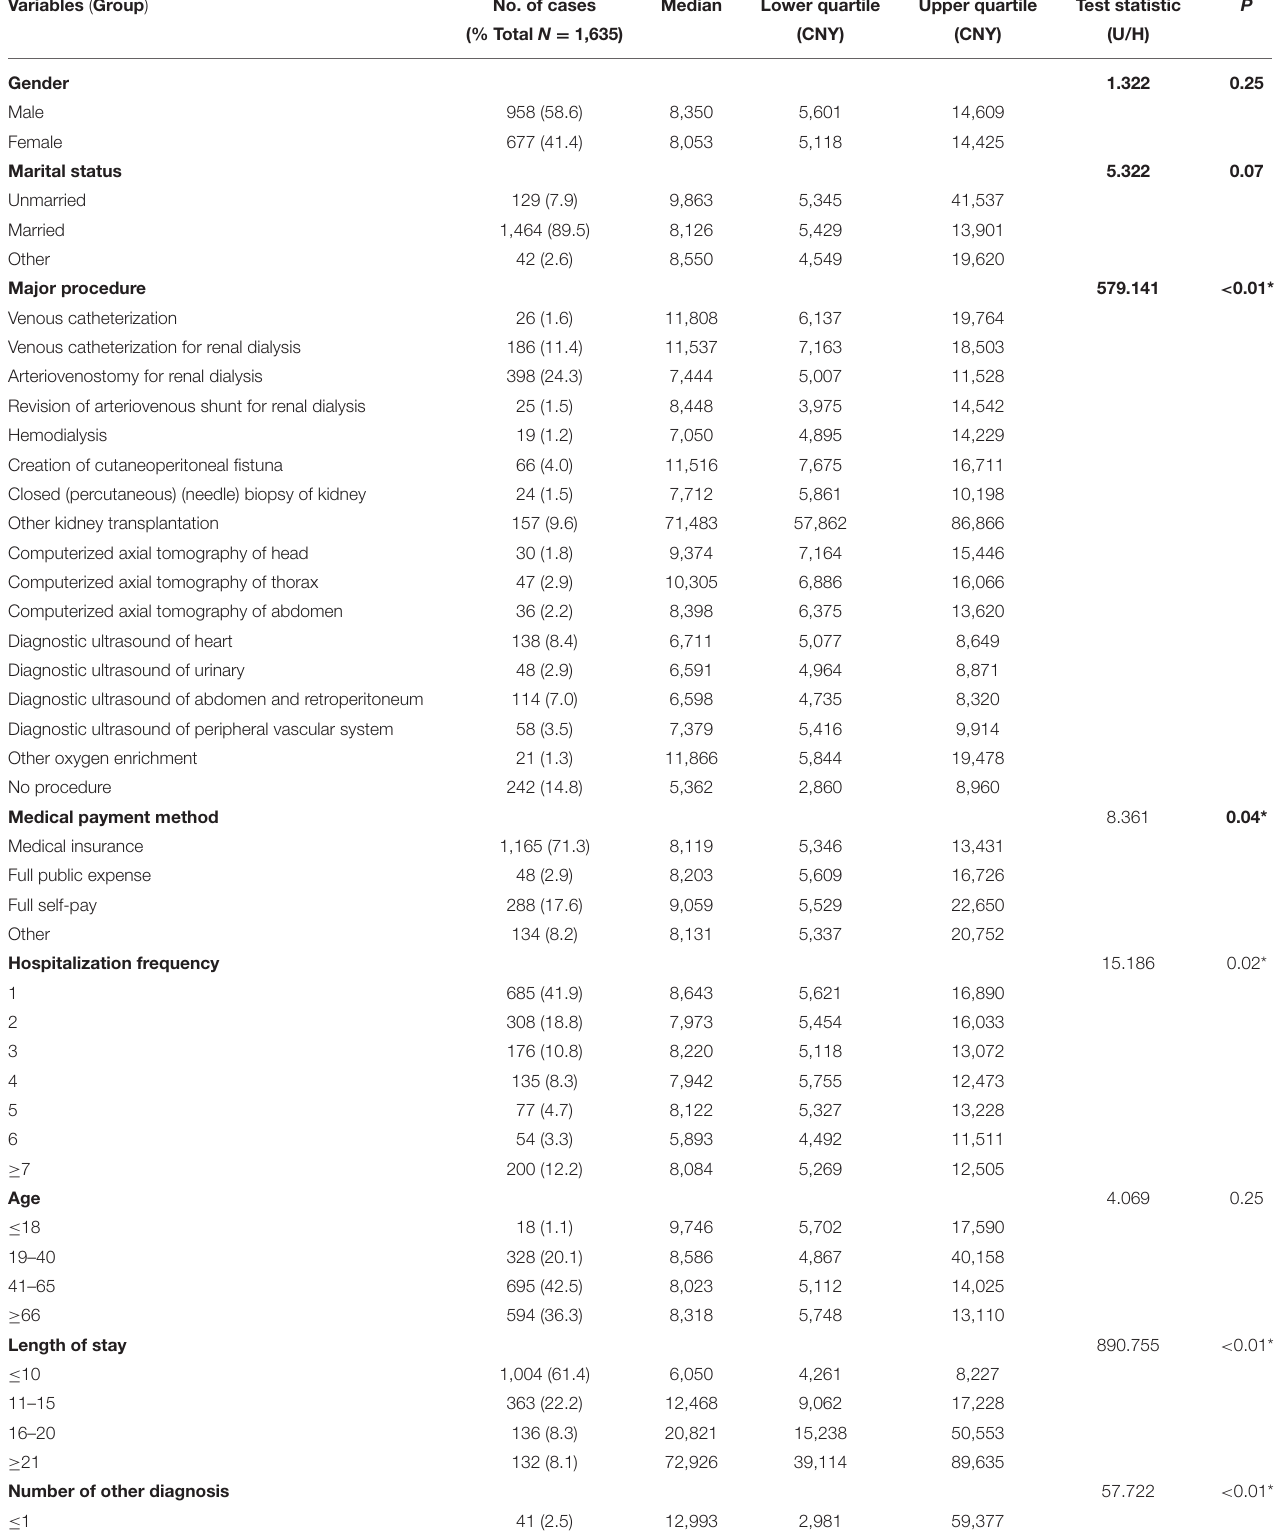
TABLE 2 | Sample characteristics and analysis of differences in hospitalization expenses of chronic renal